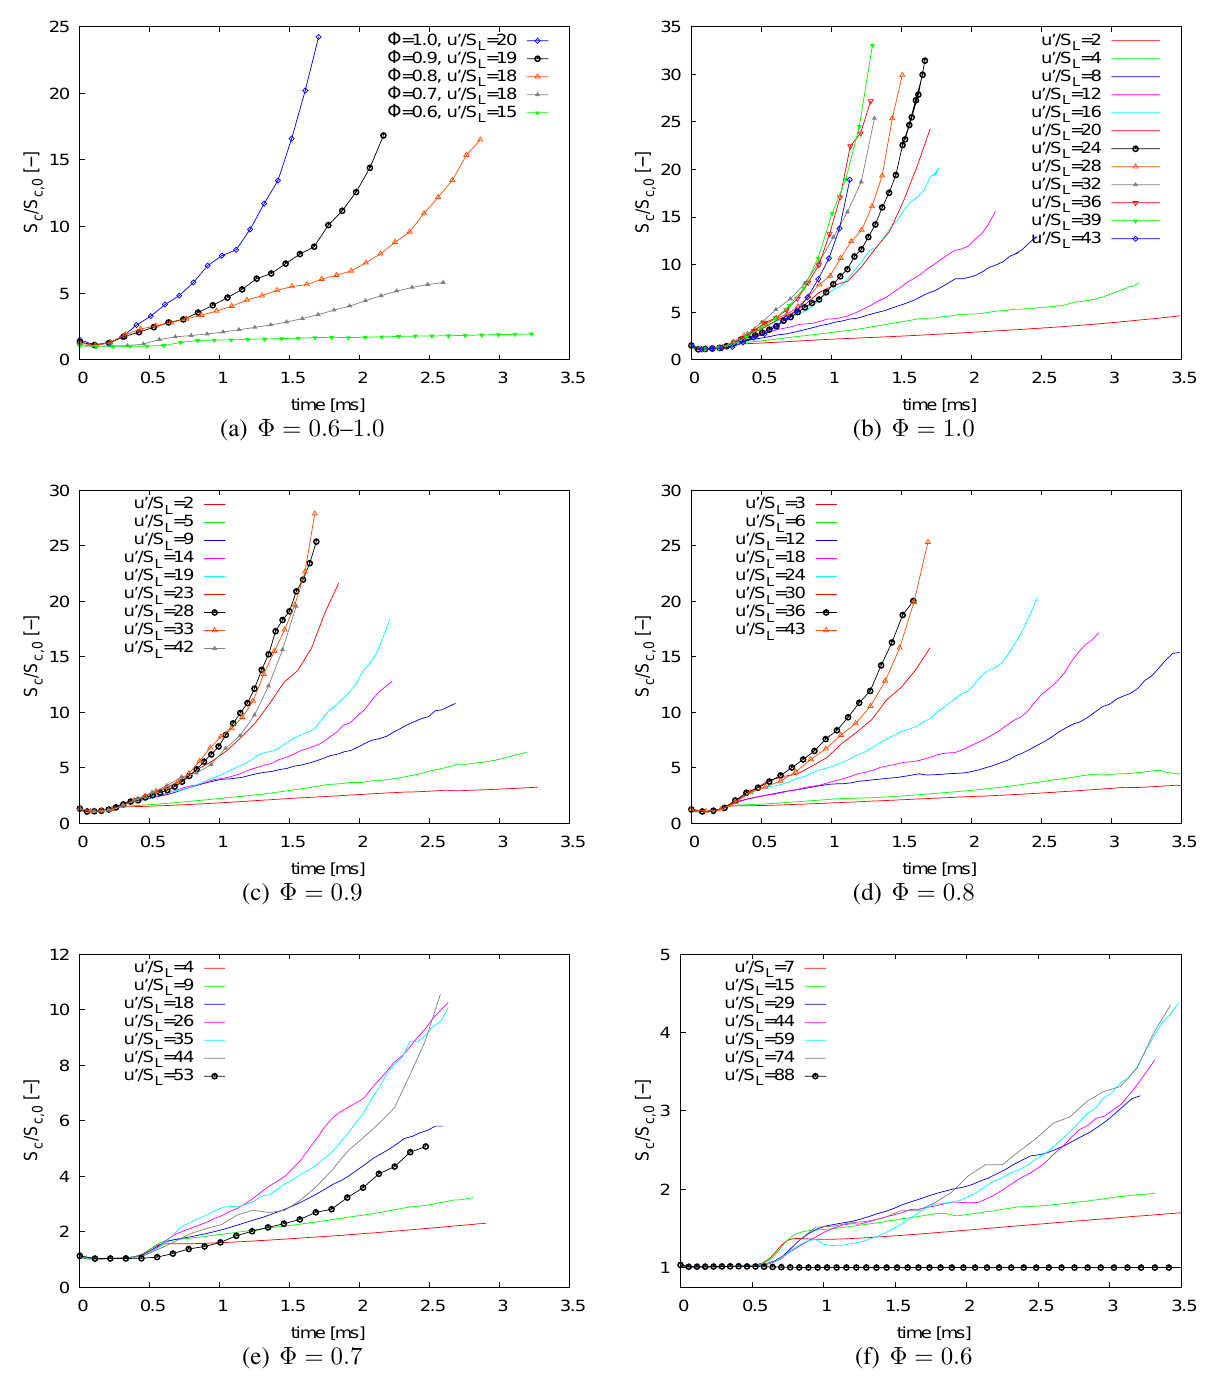
) consumption rate S 4 c and mixture equivalence ratios Φ L